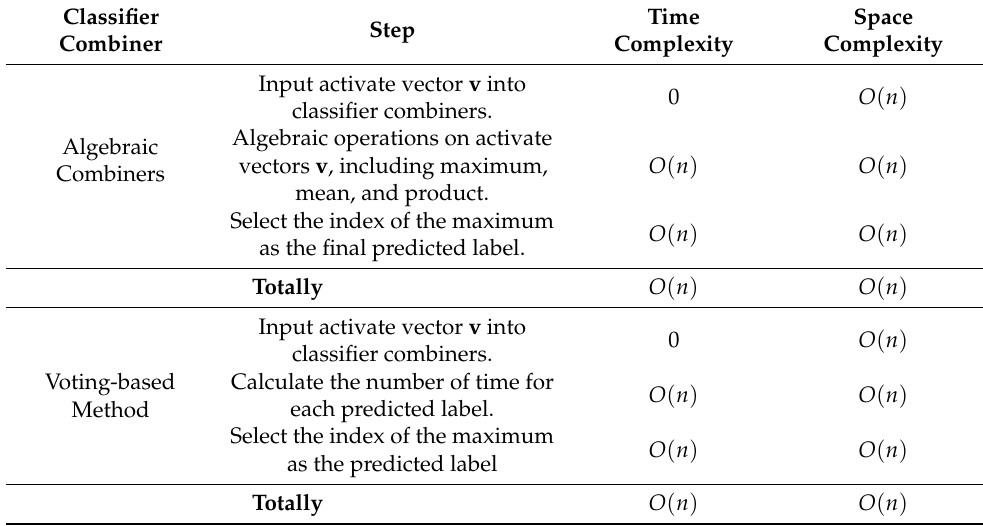
Table 3. Complexity of classifier combiners.